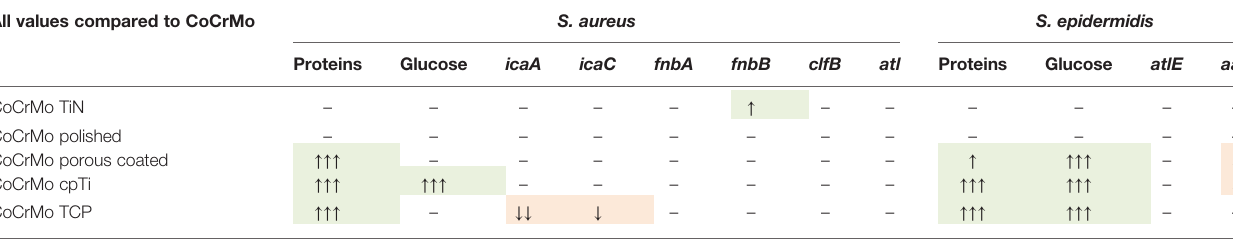
TABLE 4 | Overall comparison of the results of protein, polysaccharide and genetic measurements. All values compared to